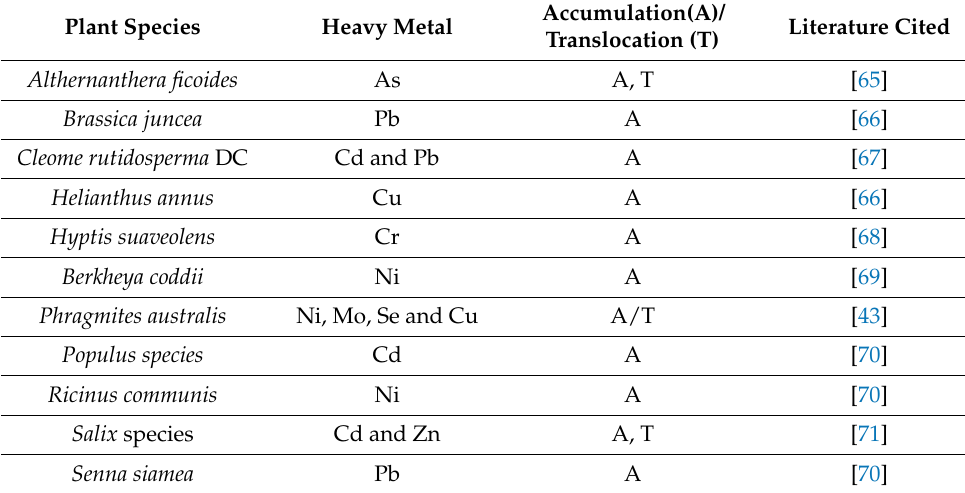
Table 3. List of potential plants used for phytoextraction